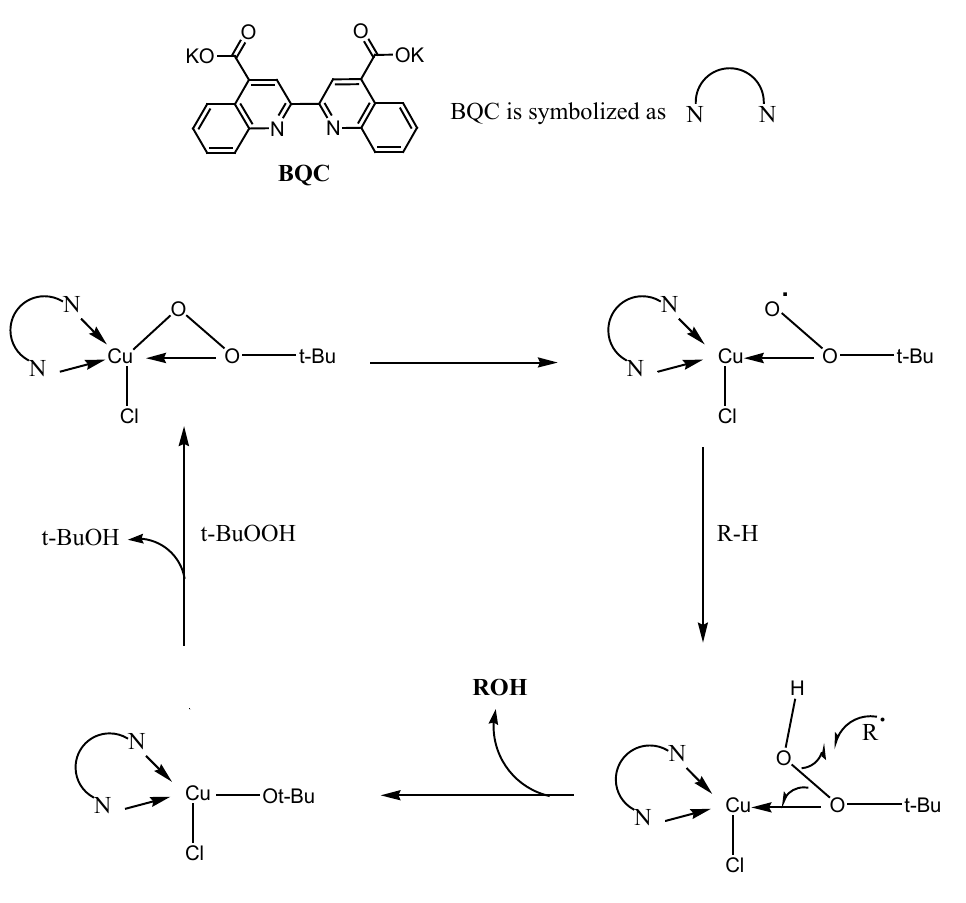
BQC is symbolized